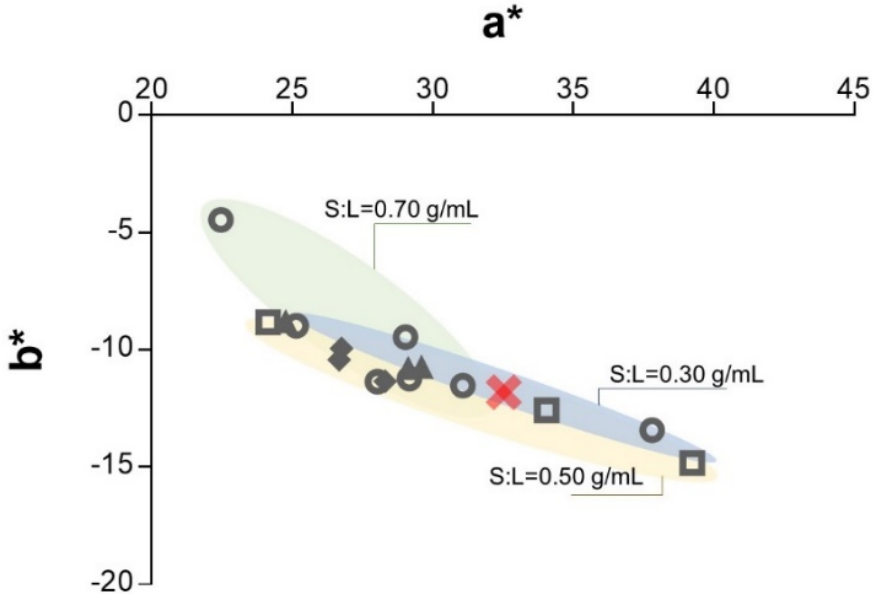
Figure 7. CIELAB parameters a* and b* as a function of the pretreatment temperature: × conventional solid–liquid extraction, □ TMW = 60 °C, ○ TMW = 80 °C, ▲ TMW = 100 °C, and ♦ TMW = 120 °C.